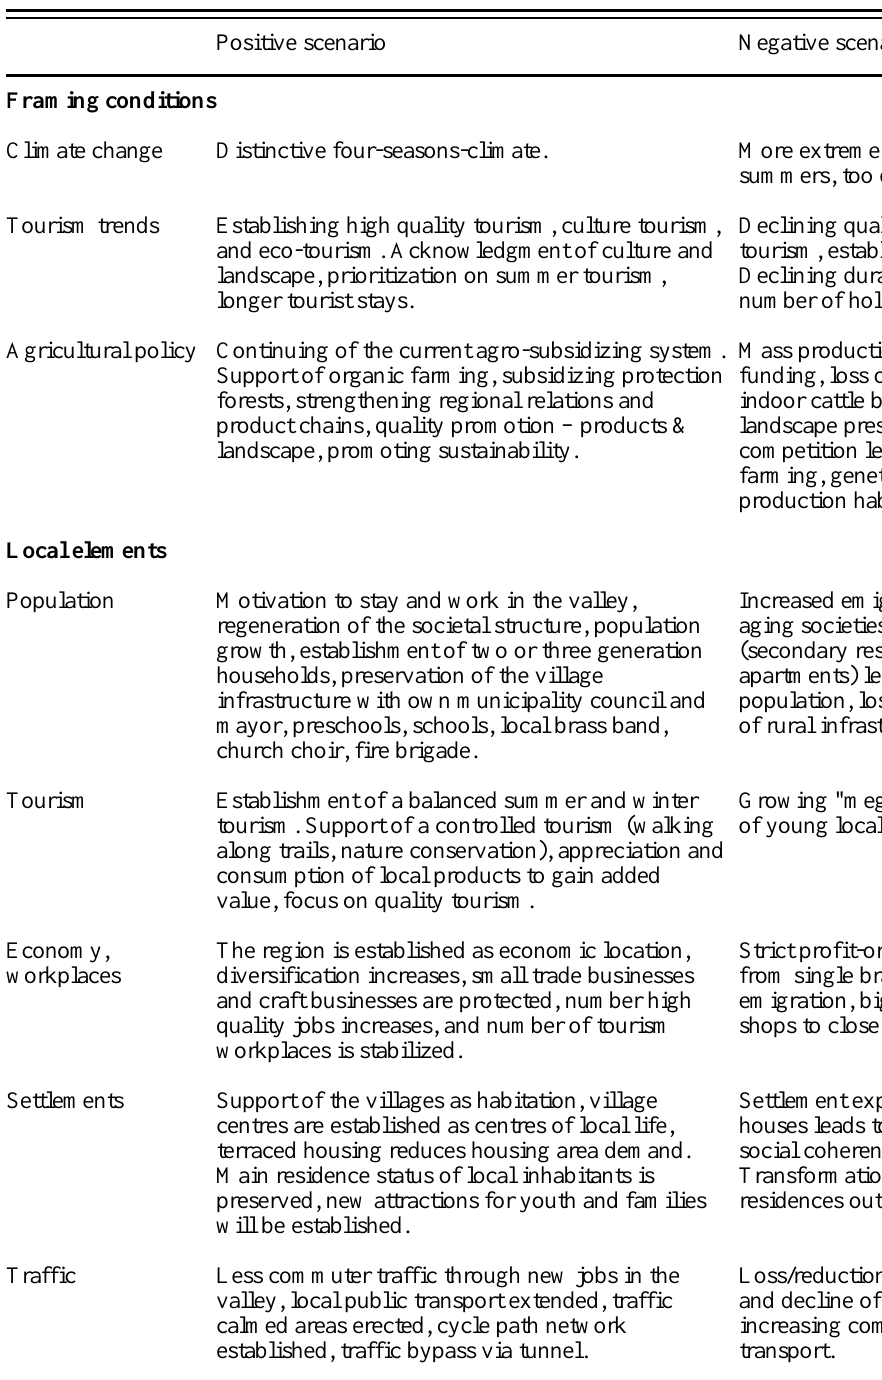
Table 1 . Future scenarios for the Montafon region – common positive and negative scenarios extracted from 3 scenario pairs carried out by 3 local stakeholder